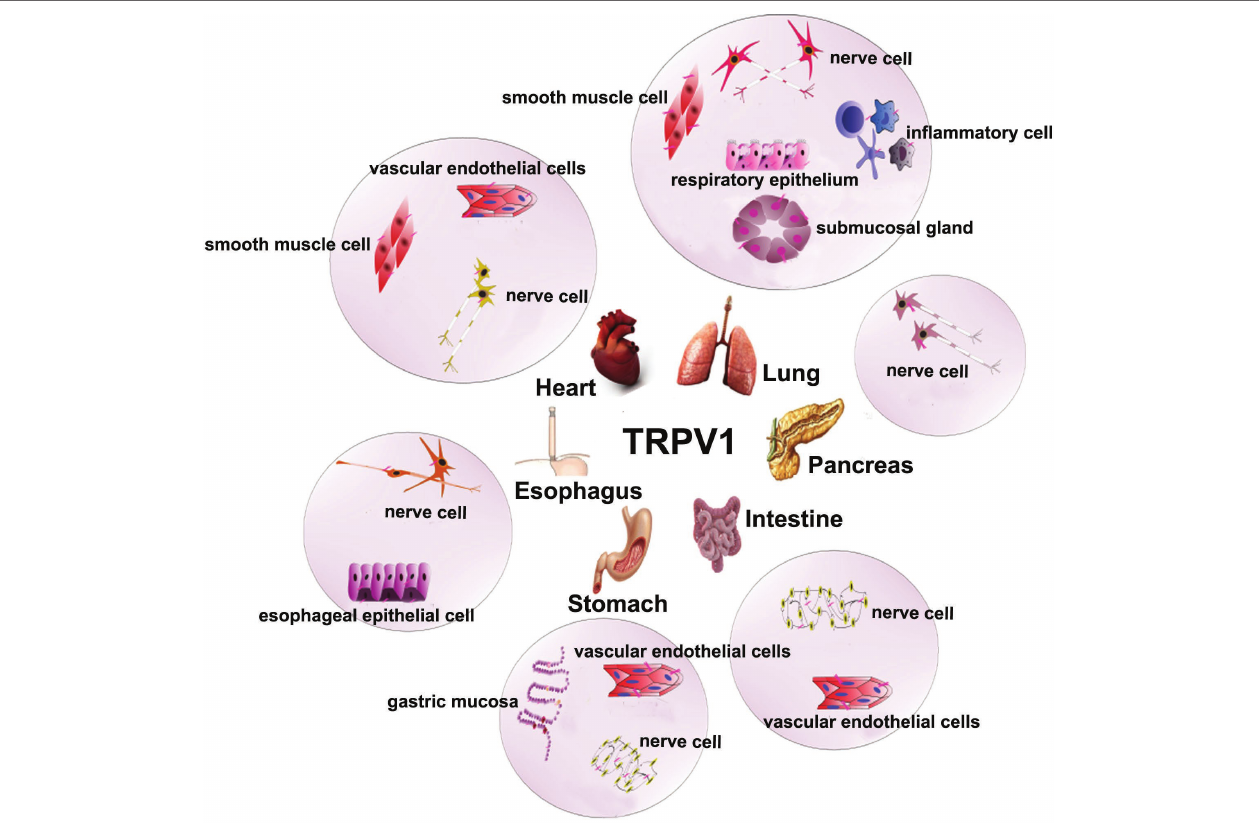
FIGURE 2 | The expression of TRPV1 in digestion, cardiovascular, and respiratory system. TRPV1 is mainly expressed nerve cells around the esophageal mucosa and blood vessels, esophageal epithelial cells in the esophagus. The submucosal plexus, myenteric plexus, vascular endothelial cell, gastric parietal cells, gastric main cells, and gastric antral G cells in the stomach. The nerve cells in pancreas. The submucosal plexus, myenteric plexus, and vascular endothelial cells in the intestine.TRPV1 is distributed in vascular peripheral nerve cells, smooth muscle cells, vascular endothelial cells in cardiovascular. It is also expressed in sensory nerve fibers, smooth muscle cells, vascular endothelial cells, submucosal glands, and inflammatory cells in the respiratory